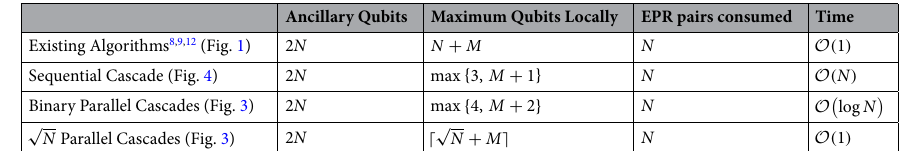
O ( N ) log N (cid:31) (cid:30)